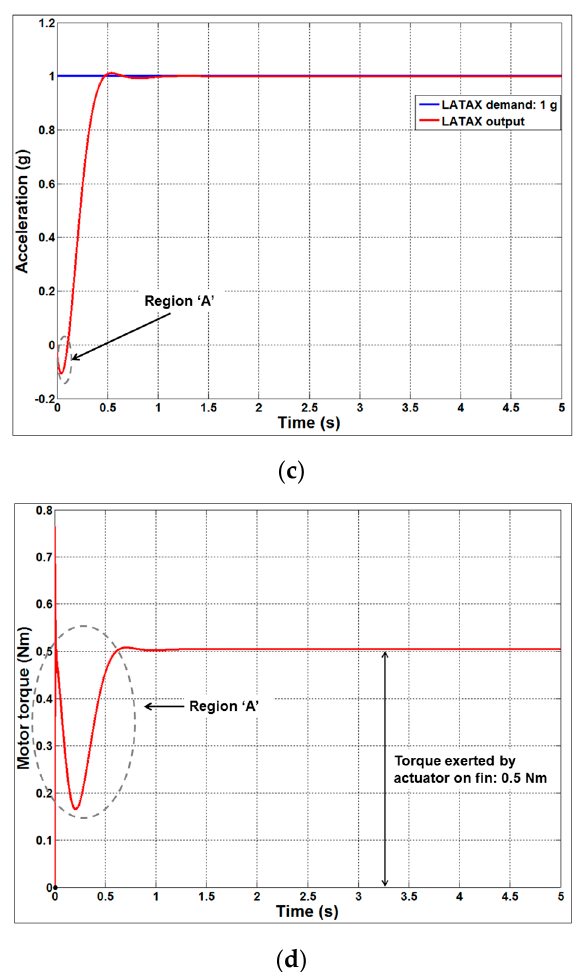
Figure 10. The 1 g step input response of the autopilot. ( a ) Speed characteristics of the actuator for a step input of 1 g; ( b ) Autopilot LATAX with respect to missile fin angle for a step input of 1 g; ( c )